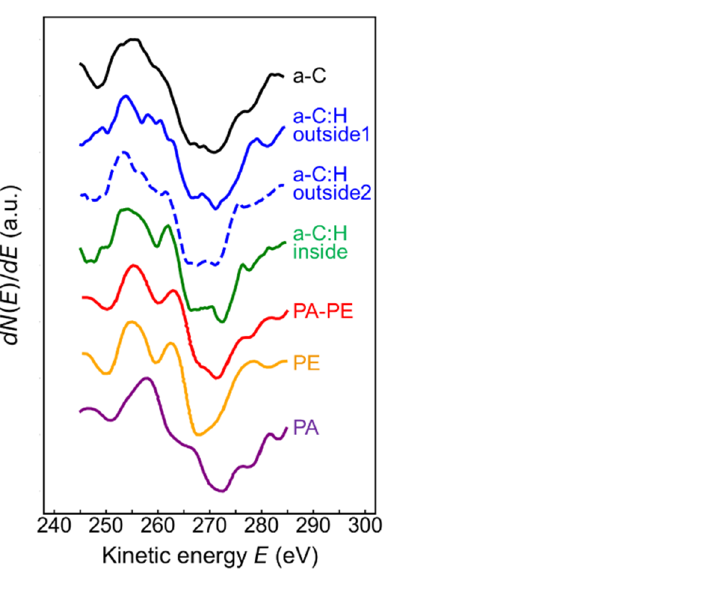
Figure 6. Comparison of first derivatives of XAES C KLL spectra for a-C (black), a-C:H outside the wear scar (blue), a-C:H inside the wear scar (green), a mixture of poly-acetylene (PA), and poly- ethylene (PE) (red), pure PE (orange), and pure PA (purple). The spectra for a-C:H outside the wear scare were obtained at two different locations (as shown in a blue solid and dashed line). The spectra for PA − PE, PE, and PA are reproduced from Lee et al. [30]. Reprinted with permission from [30]. Copyright 2018 American Chemical